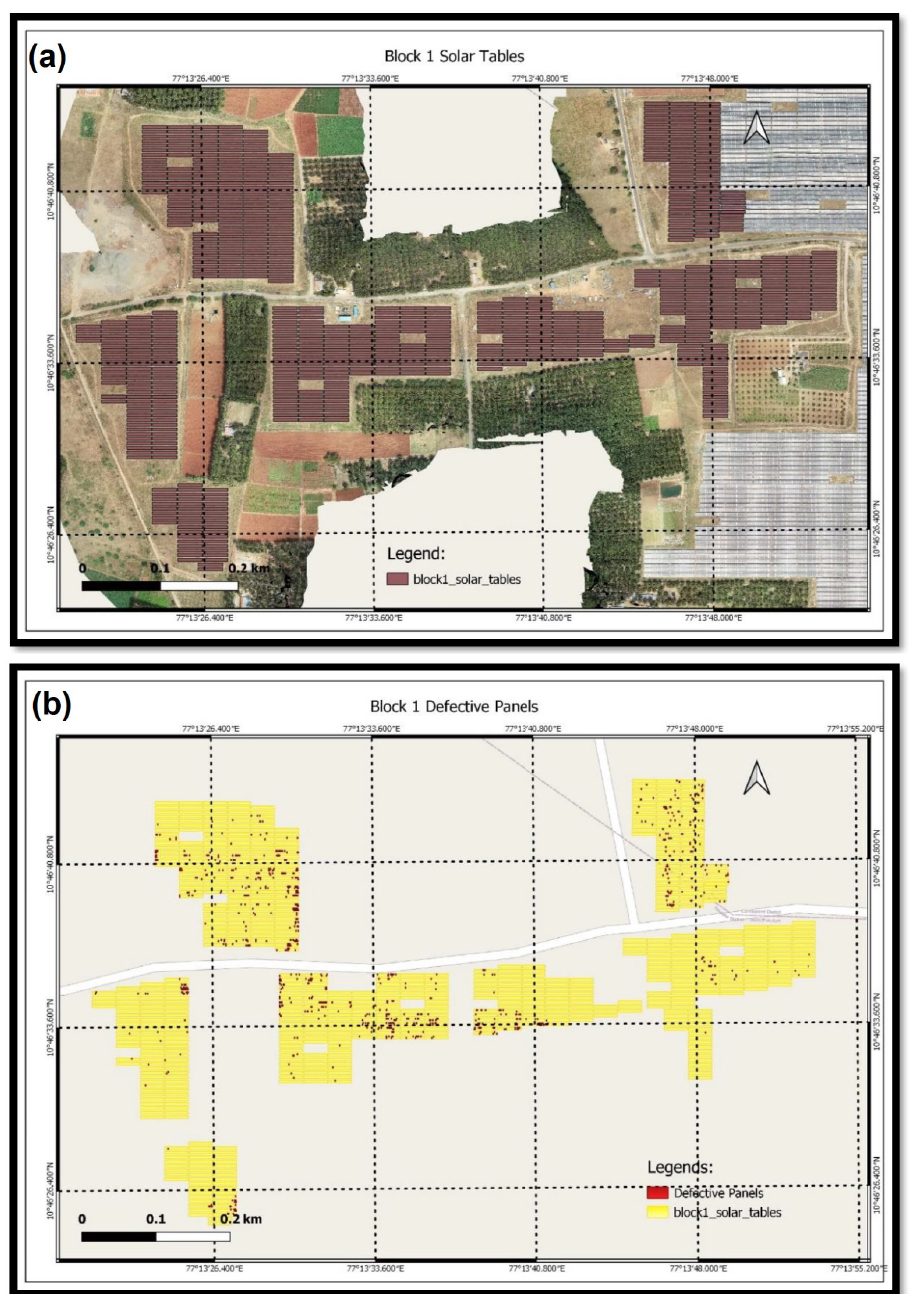
Figure 9. Block 1 solar tables ( a ) and defective panels in the same block ( b ). Table 3. Temperature statistics of hotspots. Hotspot Temp. Neighbor Temp.